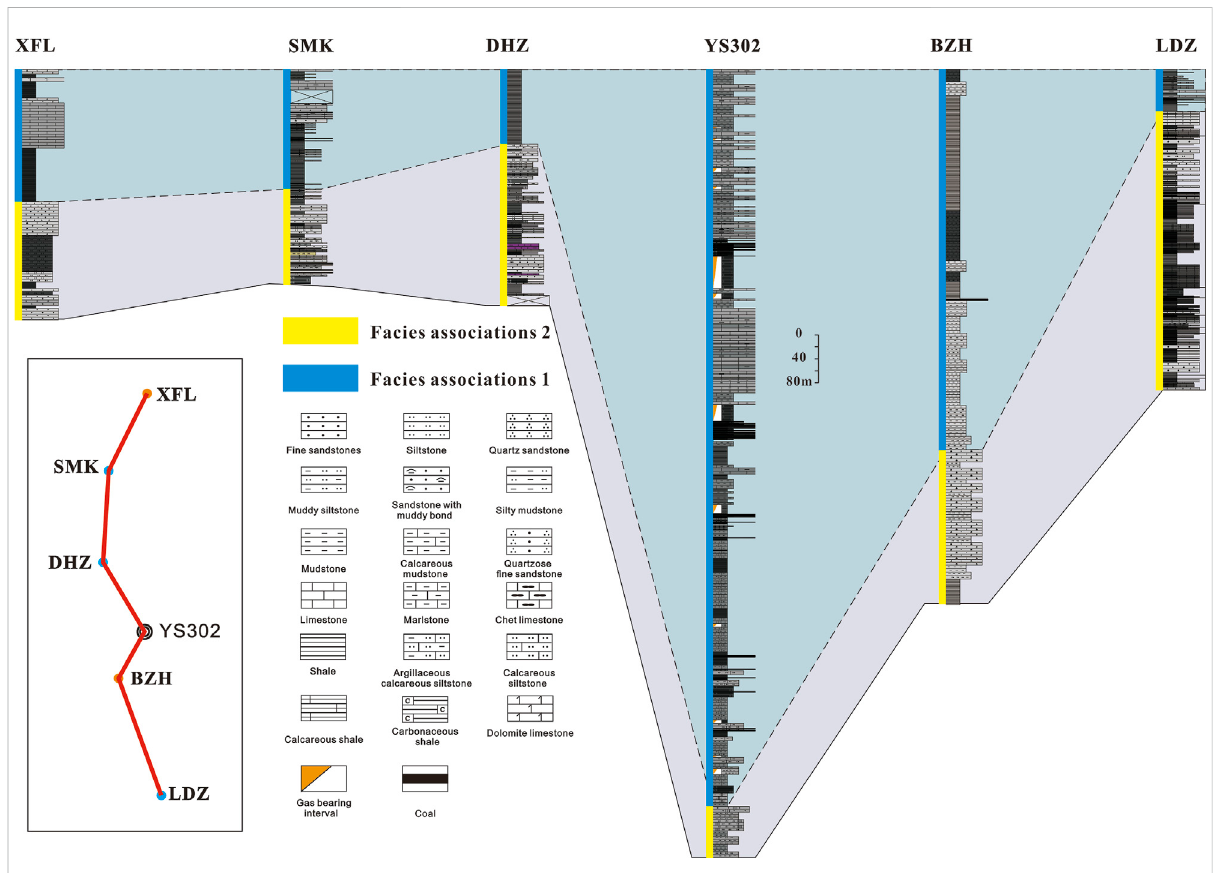
FIGURE 11 The correlation of facies of the Jiusi Formation along a north-south